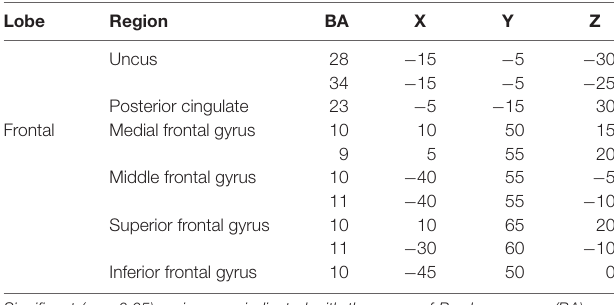
Frontiers in Aging Neuroscience |